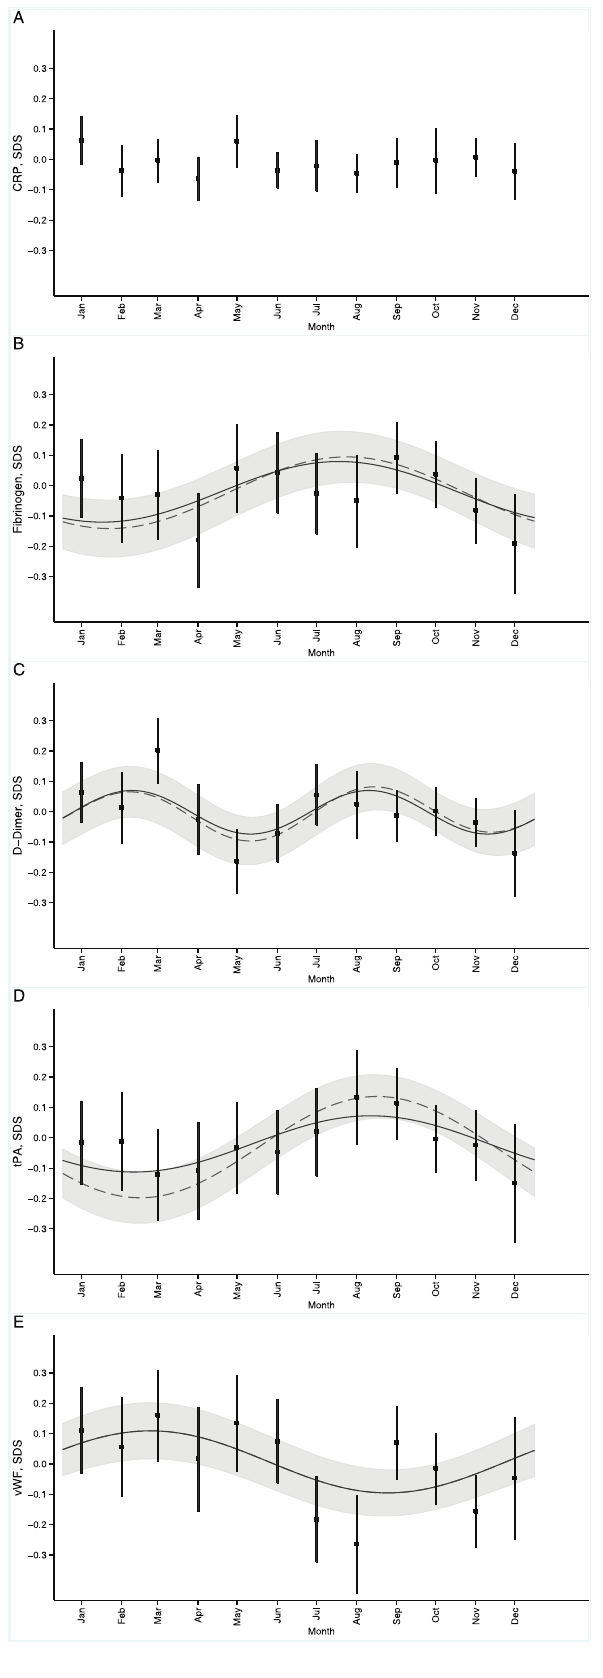
Figure 3. Seasonal variation in C-reactive protein (A), fibrino- gen (B), D-dimer (C), tissue plasminogen activator (D), and von Willebrand factor (E). Values are from the partial regression of the harmonic components; Model 1 (solid line) adjusted for respiratory infections, alcohol consumption, PC/TV time, physical activity and social class at birth and adulthood, and Model 2 (dashed line, shown with 95% confidence intervals) in addition to above adjusted for 25-hydroxyvi- tamin D. Tick marks denote average concentrations (SDS, predicted from random effects models) with 95% confidence intervals shown by error bars. Predicted means for CRP from linear models, no seasonal pattern observed (p . 0.8). *p-values from the product of coefficient mediation test used to assess the 25(OH)D mediation effect on the seasonal patterns in the outcomes.